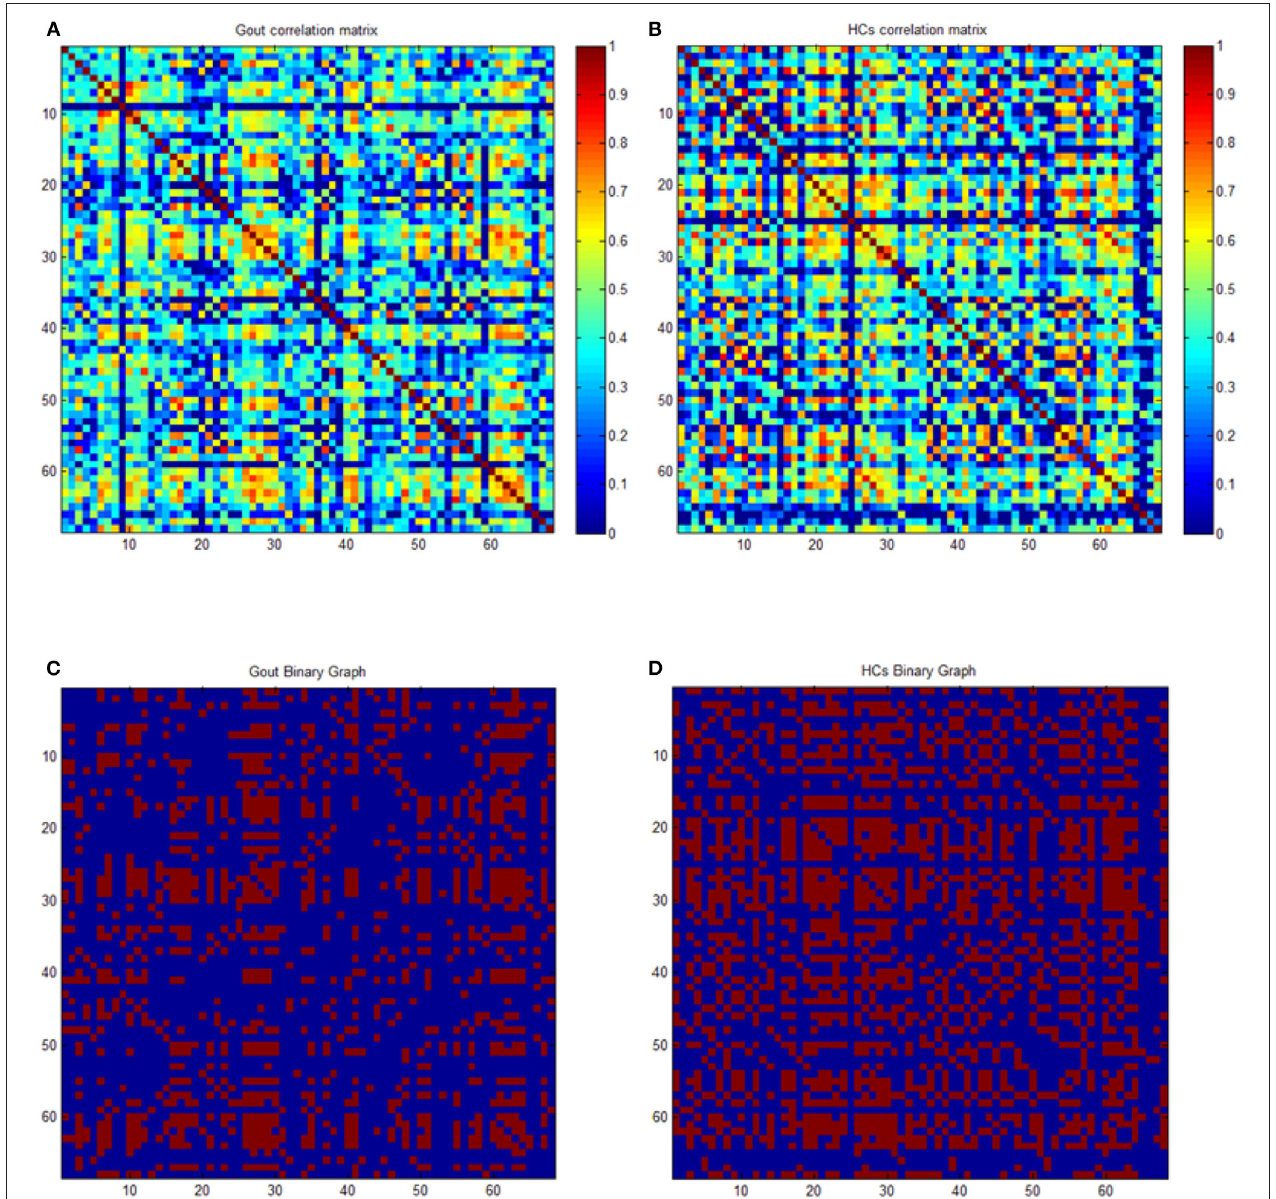
FIGURE 1 | Correlation and binary matrices for gout patients and healthy controls (HCs). Correlation matrices for gout (A) and HCs (B) , and binary adjacency matrices thresholded at Dmin (0.1) for gout (C) and HCs (D) . The color bar denotes the correlation coefficient and represents the strength of the connections.